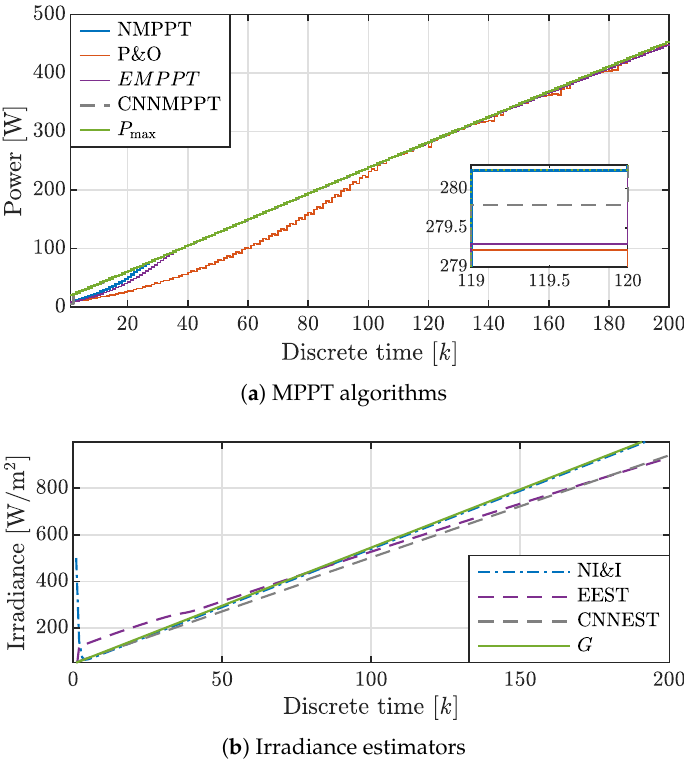
Figure 9. Comparison of the algorithms under linearly varying irradiance and temperature. Table 1. Relative error between the predicted and true maximal